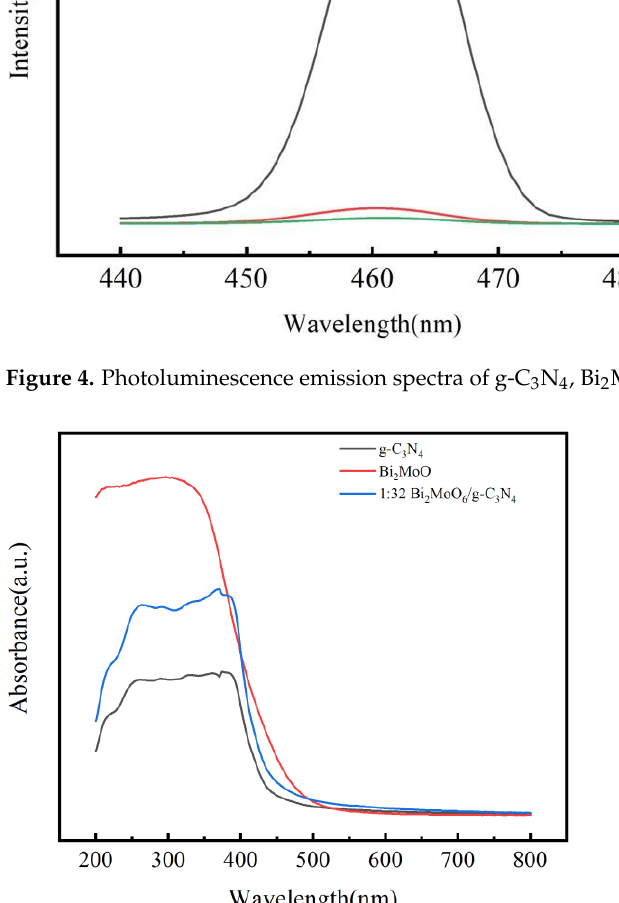
Figure 4. Photoluminescence emission spectra of g-C 3 N 4 , Bi 2 MoO 6 and 1:32 Bi 2 MoO 6 /g-C 3 N 4 .